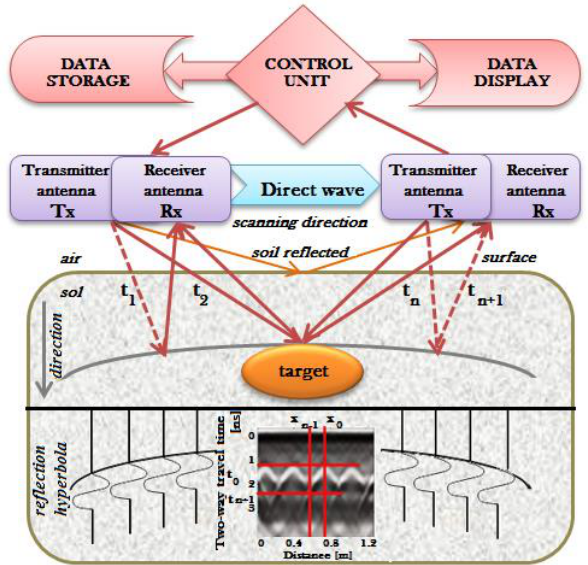
Figure 1. Process of a generic GPR system ( inset bottom -schematic diagram of GPR reflection hyperbola generation and real signal GPR B-scan).